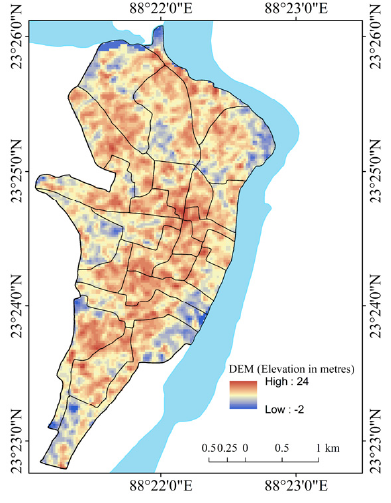
Figure 14. Relief (2000).